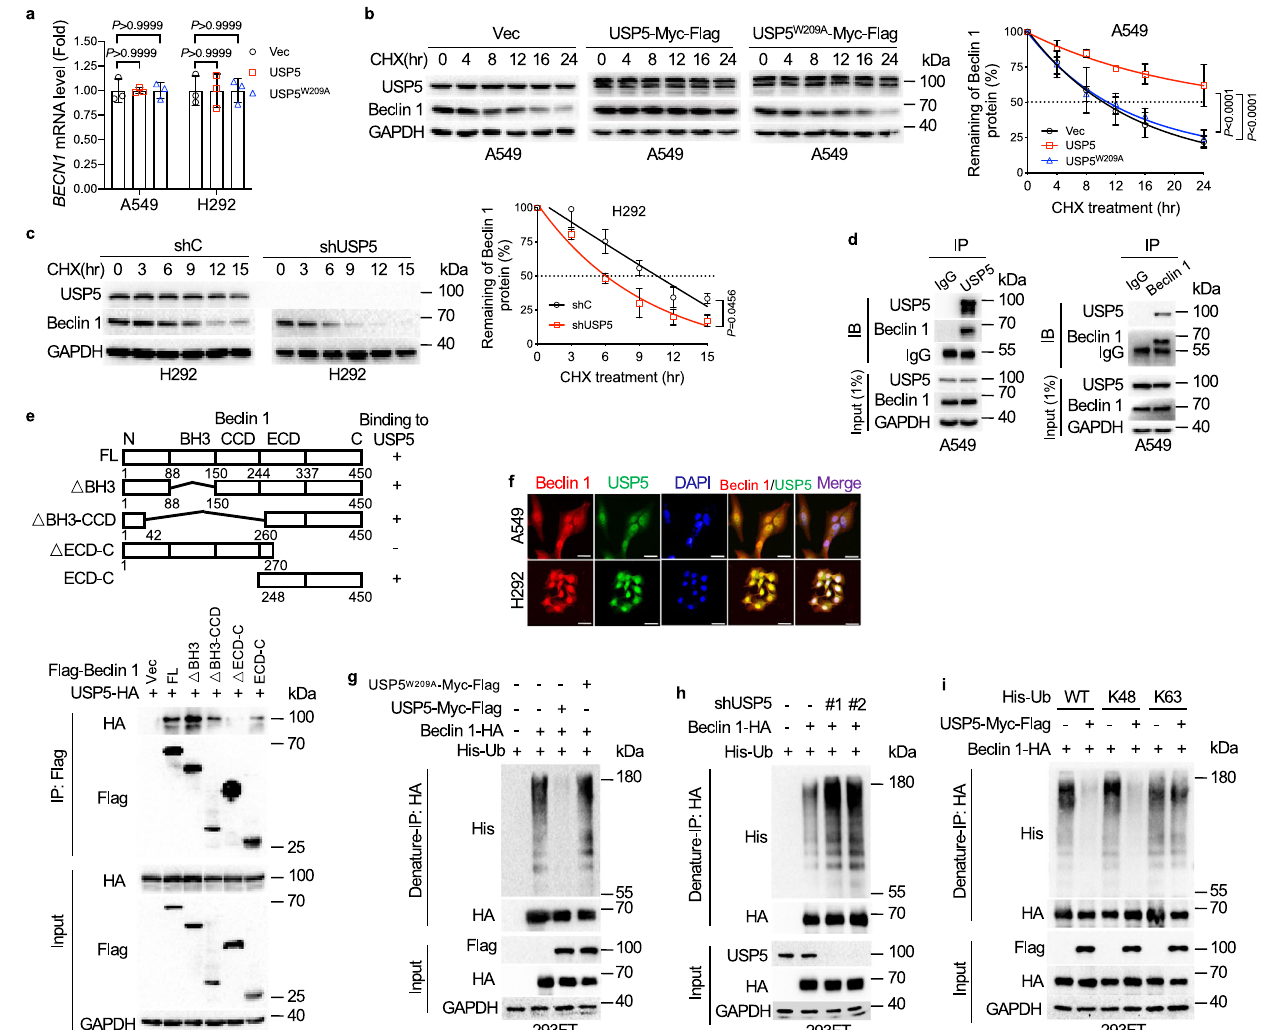
Fig. 2 | USP5 deubiquitinates and stabilizes Beclin 1. a A549 or H292 cells stably expressing USP5 or USP5 W209A were subjected to qPCR analyses for BECN1 mRNA levels. b , c A549 cellsstablyexpressing USP5orUSP5 W209A weretreated with 50 μ g/ mL cycloheximide (CHX) for the indicated time intervals ( b ). H292 cells stably expressingshUSP5weretreatedwith50 μ g/mLCHXfortheindicatedtimeintervals ( c ).Theproteinhalf-lifeplotswereobtainedbyquantifyingrelativeBeclin1/GAPDH protein bands derived from the corresponding western blots. d A549 cells were subjected to co-immunoprecipitation (co-IP) using either a speci fi c antibody for USP5, Beclin 1 or IgG control followed by western blot analyses. e A schematic diagram of Beclin 1-USP5 interaction (upper panel). 293FT cells were transfected